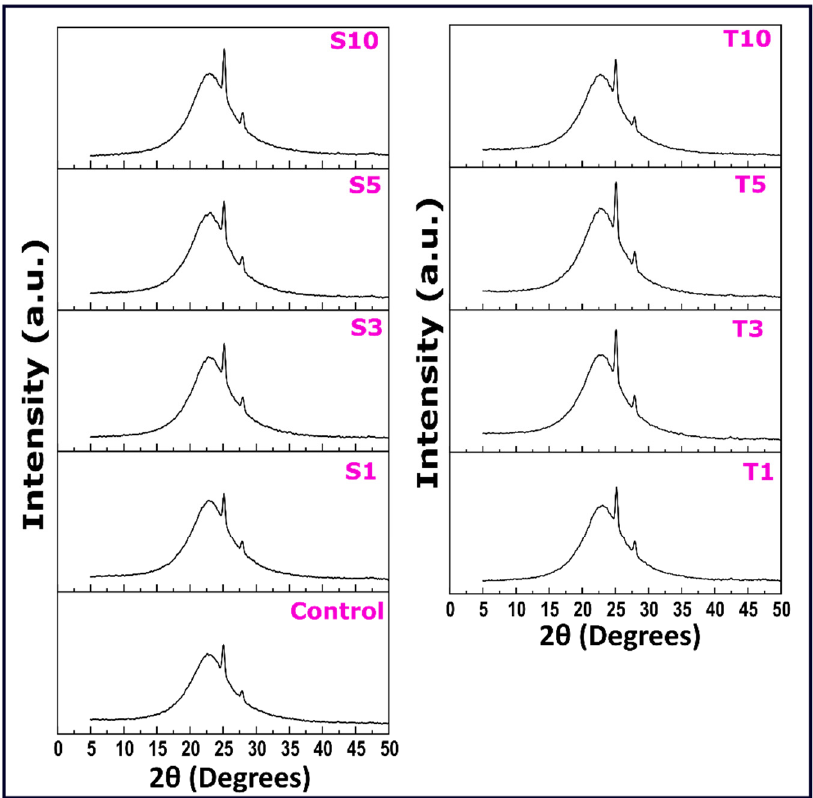
Figure 9. XRD diffractograms of oleogel formulations. The details of abbreviations used are provided in Section 4.2 (Table 5).